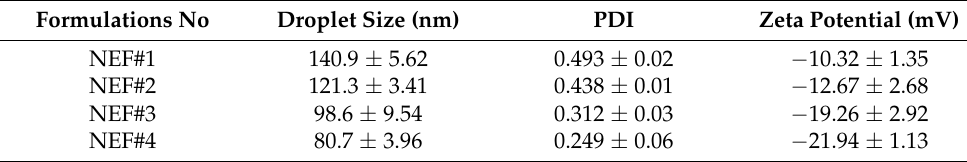
Table 4. Characterization of hemp seed oil nanoemulsion